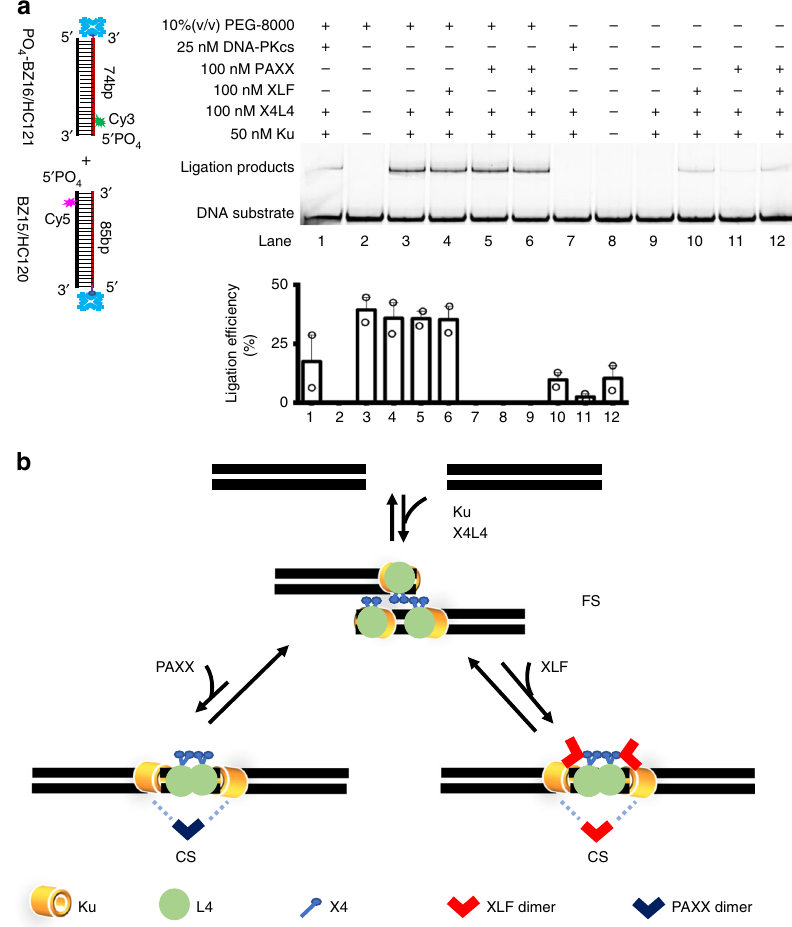
Fig. 6 Ensemble con fi rmation and the proposed model of NHEJ synapsis. a (Top) Gel results of blunt end ligation mediated by different combinations of NHEJ components in the presence and absence of 10% (v/v) PEG-8000. (Bottom) Quanti fi ed ligation ef fi ciency. Reactions 1 – 12 correspond to the reactions represented by lanes 1 – 12 in the top panel, respectively. Data are represented as mean ± SD of two independent replicates. PEG-8000 is a volume excluder, which increases the collision frequency of the two dsDNA together ready for covalent ligation. With this volume excluder in the solution, the ligation ef fi ciency was similar with or without stimulation from XLF, PAXX, or both (lanes 3 – 6). Without the volume excluder in the solution, where only NHEJ proteins would be available to bridge the two dsDNA ends for ligation, we fi nd that Ku and X4L4 cannot mediate the ligation of blunt end dsDNA (lane 9), and XLF or PAXX can stimulate the covalent ligation (lanes 10 – 12). BZ15 was synthesized with a 5 ′ PO 4 . b Ku and X4L4 mediate a fl exible synapsis ( FS ), in which two dsDNA are brought into a lateral con fi guration. Aligning the two dsDNA within the FS complex to an end-to-end state is stimulated by the XLF or PAXX protein, and XLF is the more ef fi cient one in this respect (as re fl ected by the length of the reaction arrow). One XLF dimer either interacting with X4 in X4L4 or with Ku may be suf fi cient for close synapsis ( CS ), but we speculate that more than one XLF dimer binding to both Ku and X4 may more fully stabilize the CS complex. We have not shown fi lament formation in this diagram, but for chromatinized DNA templates, it is possible that fi laments may be important 13 . Source data are provided as Source Data1 and Source Data2 fi In conclusion our results show that Ku plus X4L4 are necessary and suf fi cient for a fl exible synapsis ( FS ) of blunt end dsDNA, and that XLF can promote a transition from FS to close synapsis ( CS ), whereas DNA-PKcs is not required for synapsis (Supple- mentary Discussion). The de fi nition of FS and CS states using the